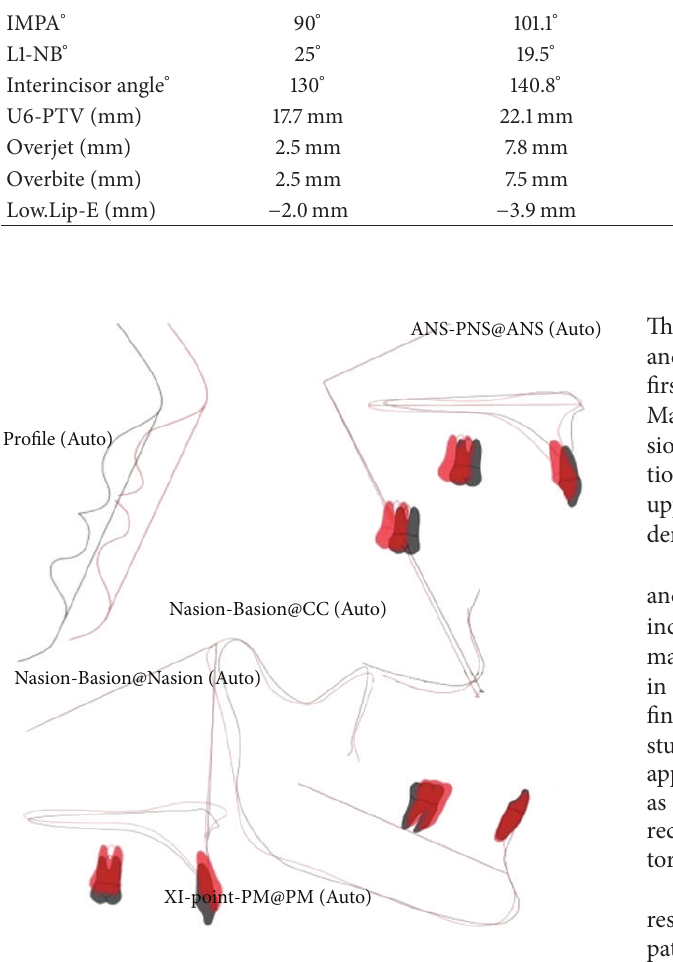
Figure 6: Superimposition (black line, pretreatment; red line,